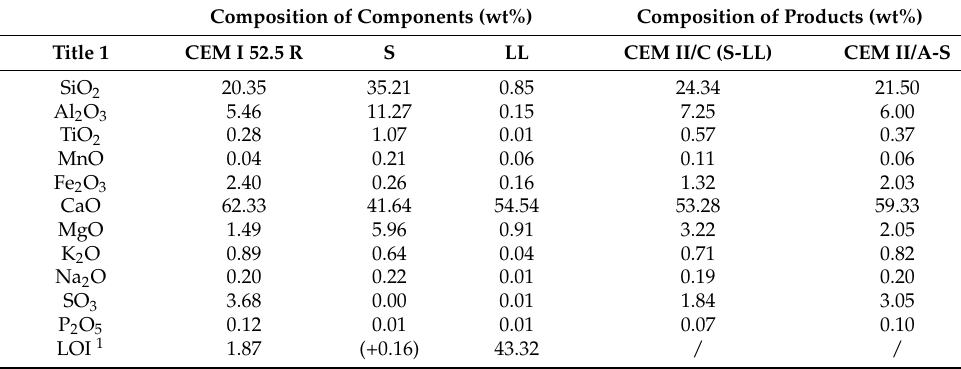
Table A1. Chemical composition of components used in the production of En cement CEM II/C (S-LL) and Ref cement CEM II/A-S, as measured with X-ray Fluorescence (XRF). The chemical composition of the products was calculated by taking into account the proportions of the components shown in Table